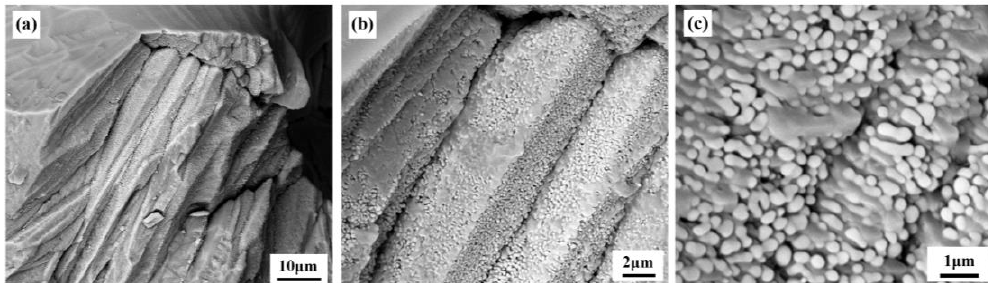
Figure 8. Back-scattered electron images showing three-dimensional configurations of faceted nano- crystalline Al 2 O 3 -ZrO 2 eutectic grains with competitive growth, produced through oxy-acetylene flame remelting. ( b ) Single-faceted grains oriented parallel to each other in ( a ). ( c ) Typical ZrO 2 rods distributed in the cores of grains. Reproduced with permission from Reference [65], Copyright © 2018 The American Ceramic Society.